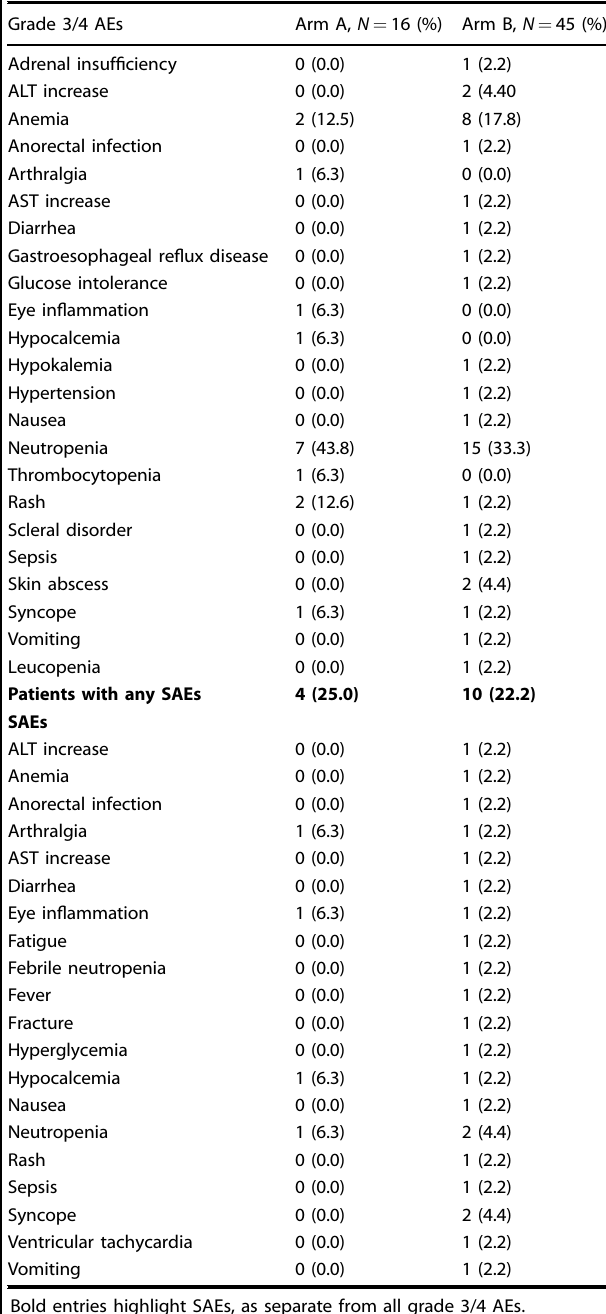
Table 2. Adverse events.